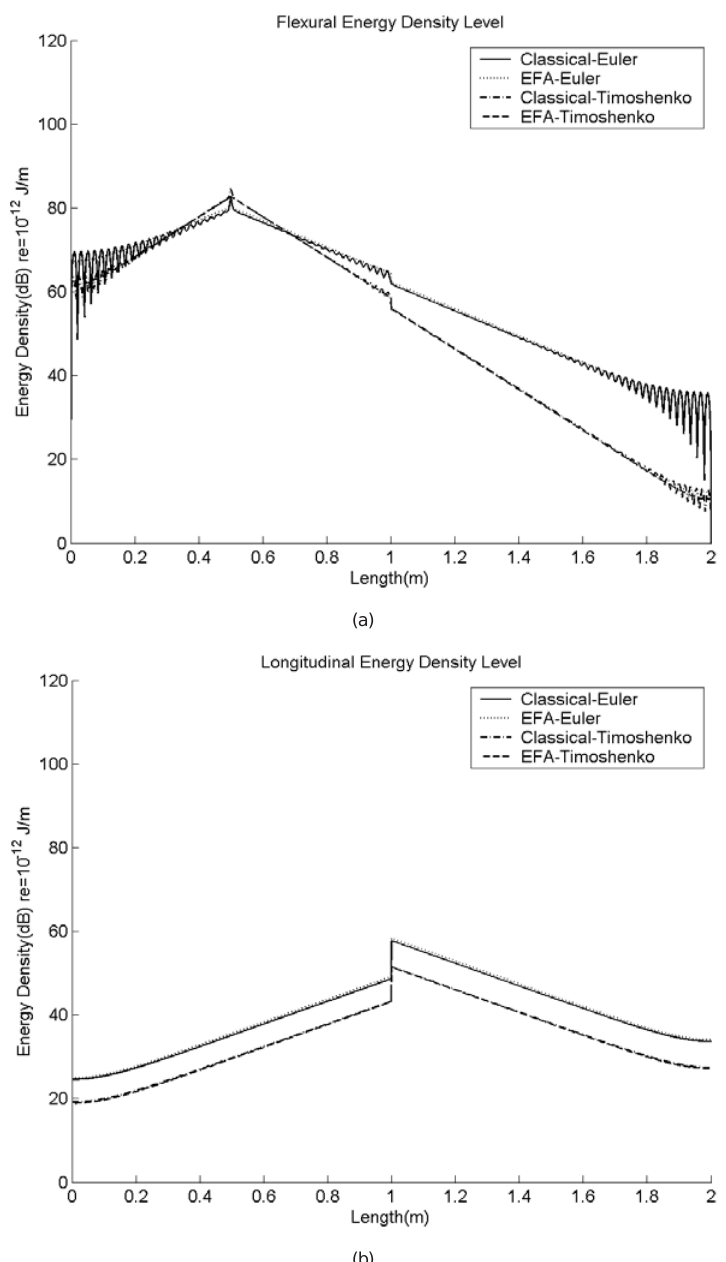
Fig. 14. The comparison of the time- and locally space-averaged energy and power levels of two Timoshenko beam with two Euler-Bernoulli beam structures coupled with θ = 45 ◦ when f = 50 kHz, η = 0 . 1 . The reference energy density is 1 × 10 − 12 J / m and the reference power is 1 × 10 − 12 W; (a) Flexural energy, (b) Longitudinal energy, (c) Flexural power, (d) Longitudinal